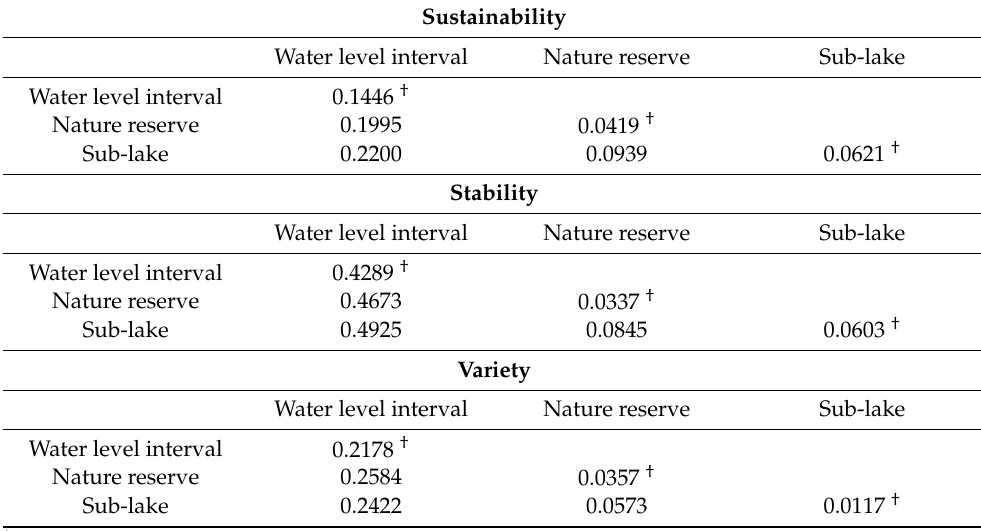
q -statistics of paired factors. Table 3 lists the results of the q -statistics of each individual factor and each pair of factors to three vulnerability indicators (the diagonal values denote the individual q -statistics of a factor and the lower triangular ones indicate the interactive q -statistics of each pair of two factors). Table 3. Explanatory powers and the paired interactive effects of the water level interval, nature reserve, and sub-lake on the vulnerability of crane